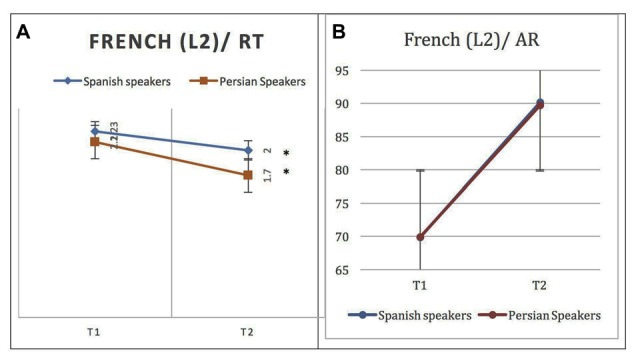
Behavioral results for naming L2 (French) words at phase 1 (after a week) and phase 2 (after 4 weeks) in native Persian and Spanish speakers: (A) Response time (RT) in seconds (s). (B) Accuracy rate (AR) in percentage. A significant difference is observed across phases for RT but AR overlaps. Error bars show one standard deviation (SD) from the mean. Asterisks (*) indicate that the result is statistically significant.